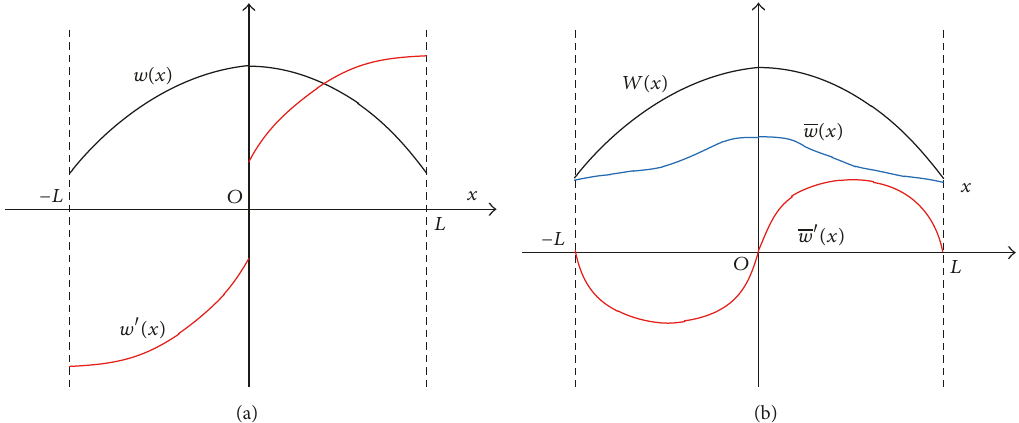
Figure 4: An illustration of the possible discontinuities of the displacement at the end points and how they can be equivalently removed